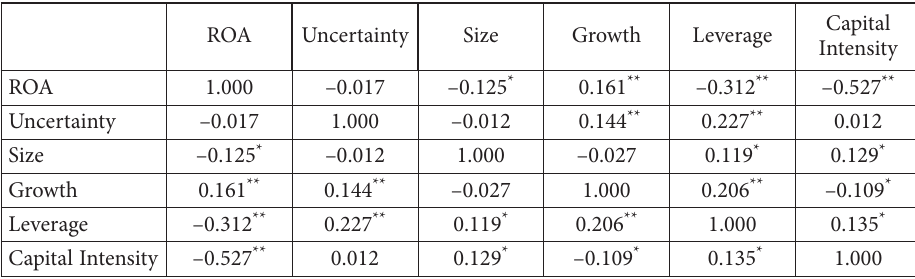
Table 4. Pearson correlation